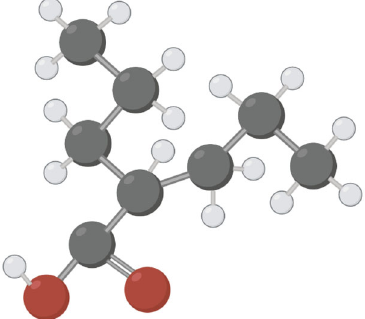
Figure 1. 3D scheme of valproic acid molecule.